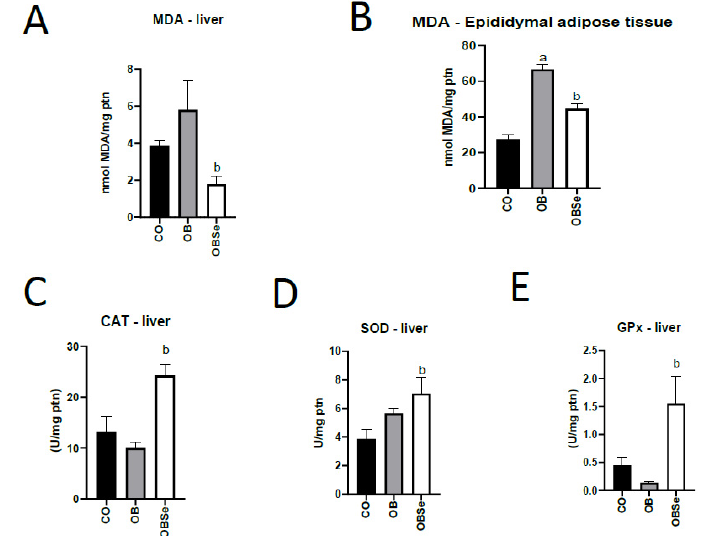
Figure 4. Effect of high-fat obesogenic diet and Se supplementation on MDA levels in liver ( A ) and epididymal adipose ( B ) and hepatic antioxidant enzyme activities (CAT [ C ], SOD [ D ] and GPx [ E ]). Data represent the mean ± SEM ( n = 5/group). Statistically significant difference ( p ≤ 0.05) compared to a CO and b OB groups according to one-way ANOVA, followed by Tukey’s multiple comparisons test.